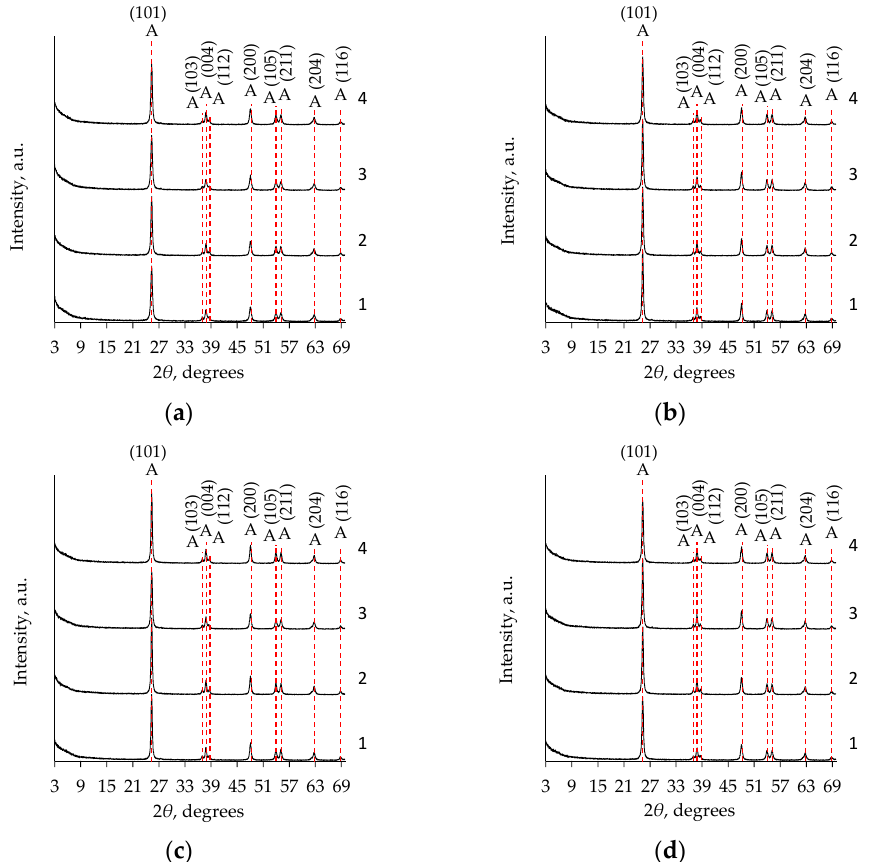
Figure 8. The effects of calcination on the TiO 2 aerogel XRD patterns after subcritical drying (800 mbar, 70 °C, 8 h) in relation to the precursor (TIP ( a , b ), TBOT ( c , d )), ageing (without aging ( a , c ), aged ( b , d )), and additional solvent exchanges (1—without exchange; 2—CH; 3—nH; 4—DE). Indices: A—anatase phase. Table 3. Variation in crystallite size depending on the TiO 2 aerogel synthesis conditions.